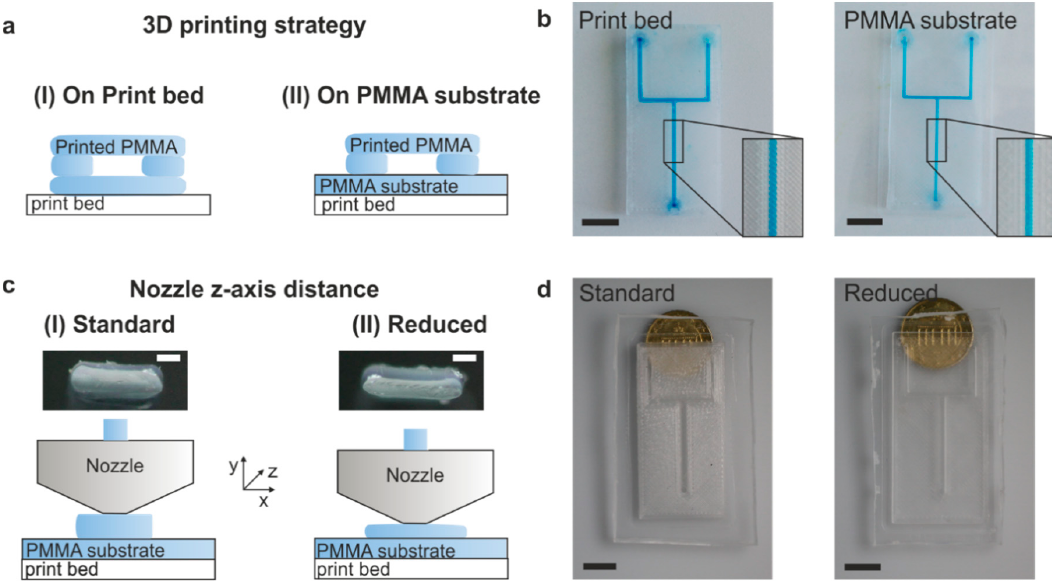
Figure 1. Fused deposition modeling of microfluidic chips in polymethylmethacrylate (PMMA). ( a ) Principle of printing microfluidic PMMA channels. PMMA was either directly printed on the print